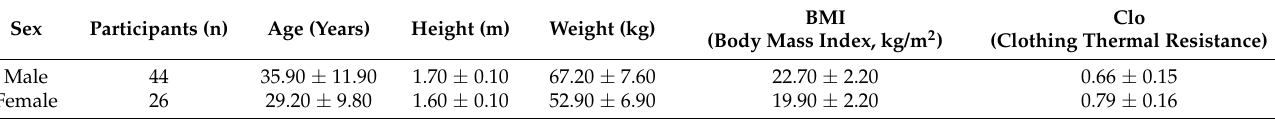
Table 1. Demographics of participants.